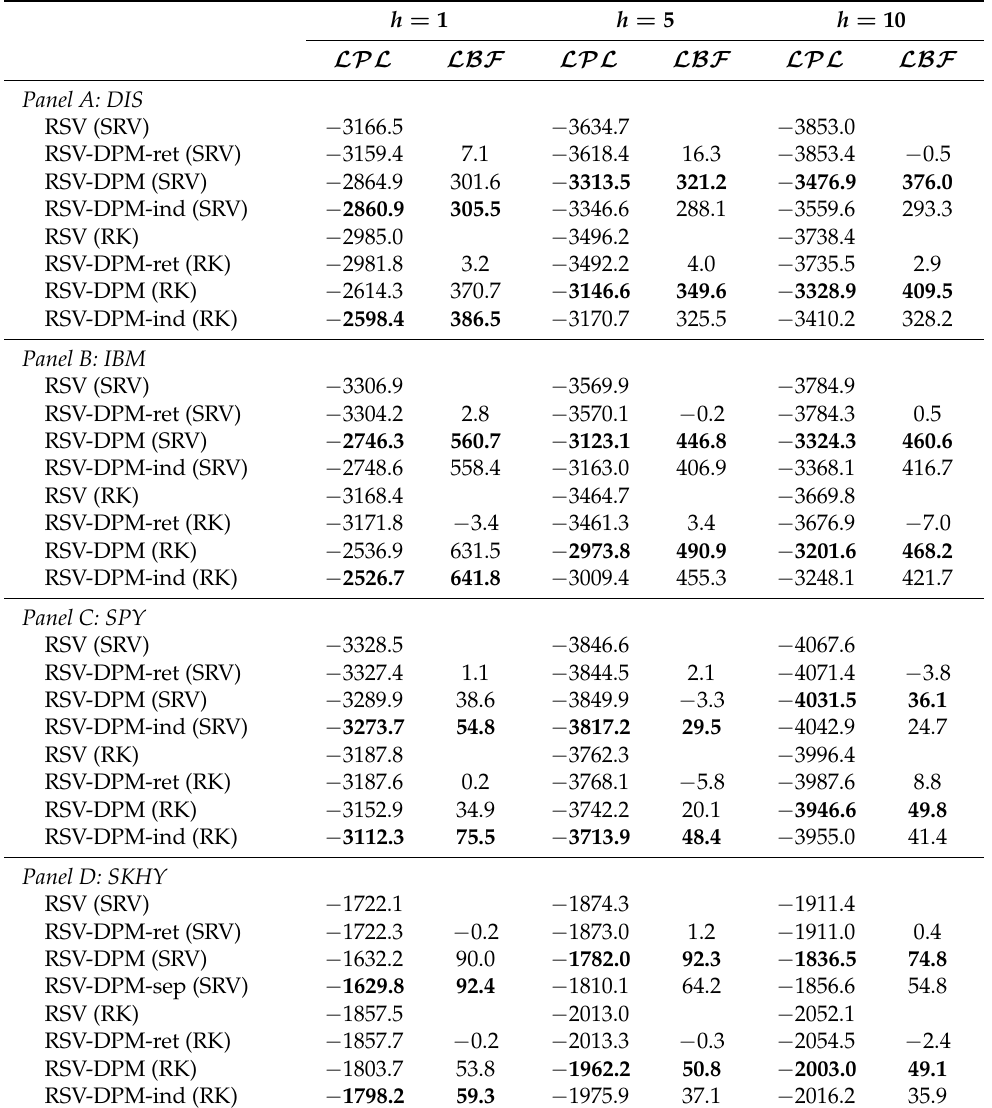
Table 4. Density forecasts of log realized volatility